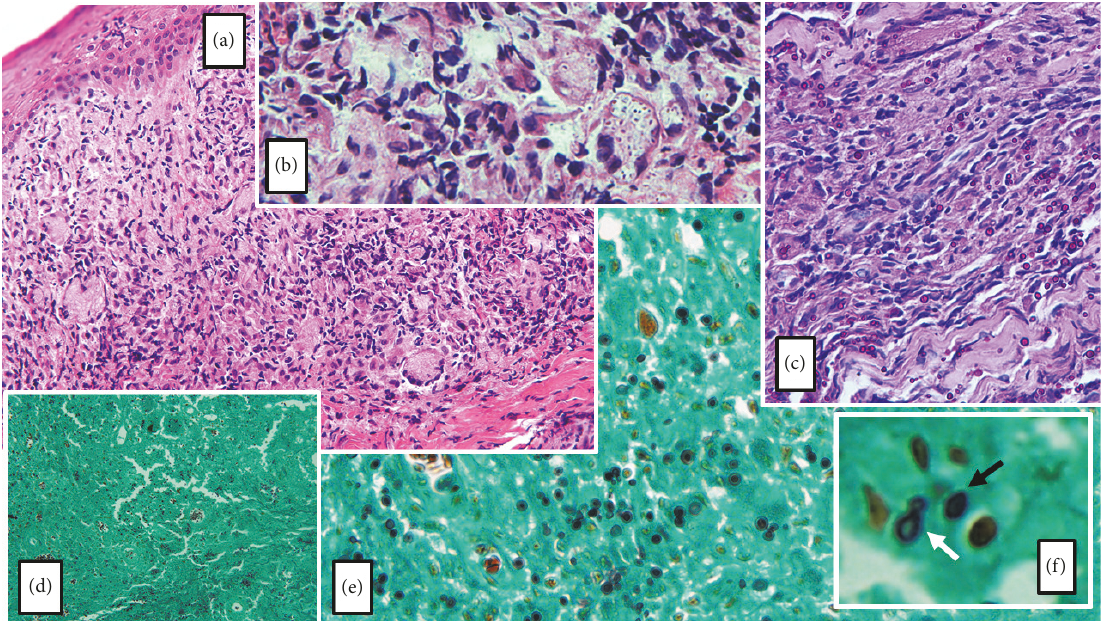
Figure 2: (a) Hematoxylin and eosin stain (original magnification 100x) discloses a dermal chronic granulomatous inflammatory reaction, with the presence of Langhans giant cells, epithelioid histiocytes, plasmocytes, neutrophils, and eosinophils. (b) Hematoxylin and eosin stain (original magnification 400x) shows abundant rounded structures located inside multinucleated giant cells and histiocytes. (c) Periodic acid-Schiff stain (original magnification 200x) discloses spherical fungal elements. (d) and (e) Grocott’s methenamine silver stain (original magnification 100x and 200x, resp.) unmasks countless 2 to 6 𝜇 m darkly stained round to oval, as well as some cigar-shaped, elongated unicellular yeast-like structures, consistent with Sporothrix spp. (f) A cigar-shaped structure (black arrow) and a narrow-based budding yeast (white arrow) are shown in